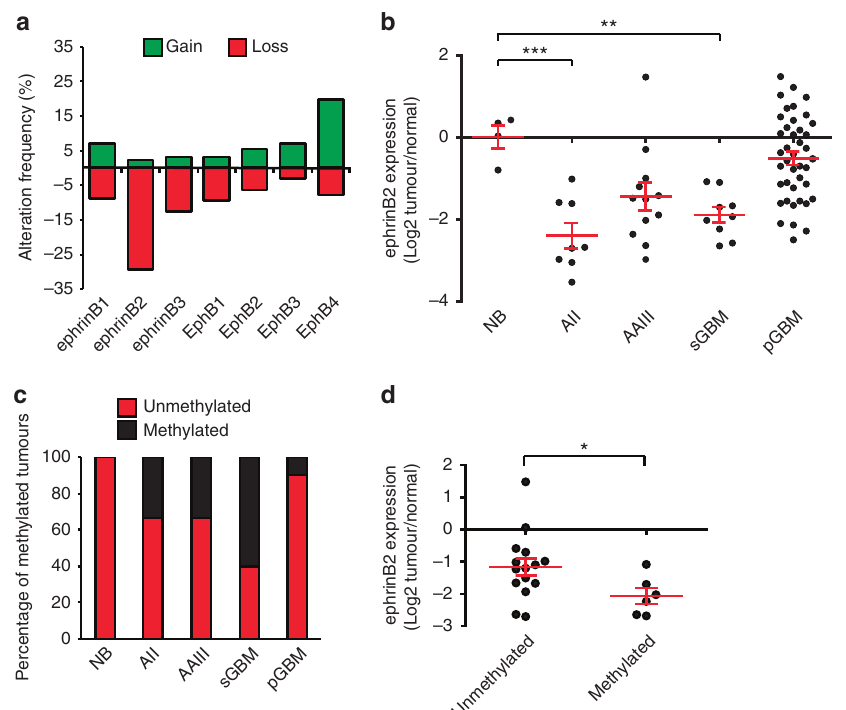
Figure 1 | EphrinB2 expression is downregulated in gliomas. ( a ) Copy number alterations of EphB/ephrinB family members in a panel of WHO grade II, III and IVgliomas as detected by array-CGH analysis ( n ¼ 127). ( b ) Expression of ephrinB2 mRNA relative to normal brain tissue samples in a microarray data set 22 , in a panel of WHO grade II–IV astrocytic gliomas. AII, diffuse astrocytoma, WHO grade II ( n ¼ 8); AAIII, anaplastic astrocytoma, WHO grade III ( n ¼ 12); NB, normal brain tissue ( n ¼ 4); sGBM, secondary glioblastoma, WHO grade IV ( n ¼ 9); pGBM, primary glioblastoma, WHO grade IV ( n ¼ 41). ( c ) Frequency of ephrinB2 promoter CpG hypermethylation in normal brain and astrocytic gliomas of different WHO grades ( n ¼ 29). ( d ) Comparison of ephrinB2 mRNA levels in gliomas with or without ephrinB2 promoter methylation ( n ¼ 21). Data are means ± s.e.m. * P o 0.05, ** P o 0.01, *** P o 0.001 using one-way analysis of variance (ANOVA) with Bonferroni post-test P o 0.0001 ( b , ANOVA P o 0.0001) or Student’s t -test ( d